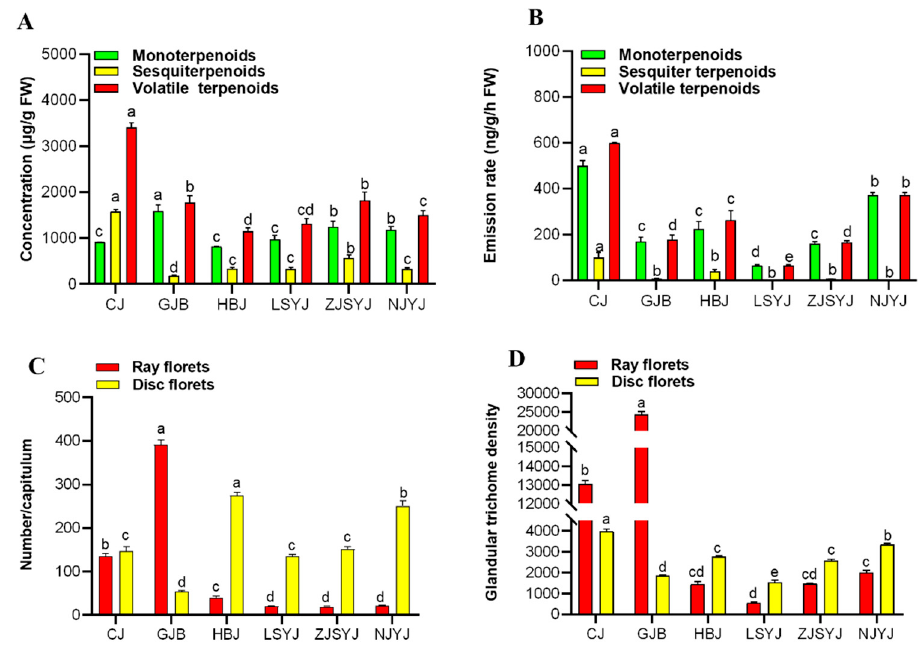
Figure 5. Glandular trichome density and terpene content for the ray florets and disc florets of three cultivars of C. morifilium (‘CJ’, ‘GJB’ and ‘HBJ’) and three accessions of C. indicum (‘LSYJ’, ‘ZJSYJ’ and ‘NJYJ’): concentration ( A ) and emission rate of terpenoids ( B ); number of ray florets and disc florets per flowerhead ( C ); density of glandular trichomes on ray florets and disc florets ( D ). Different letters in ( A – D ) denote statistically significant differences among cultivars \ accessions according to ANOVA analysis ( p <